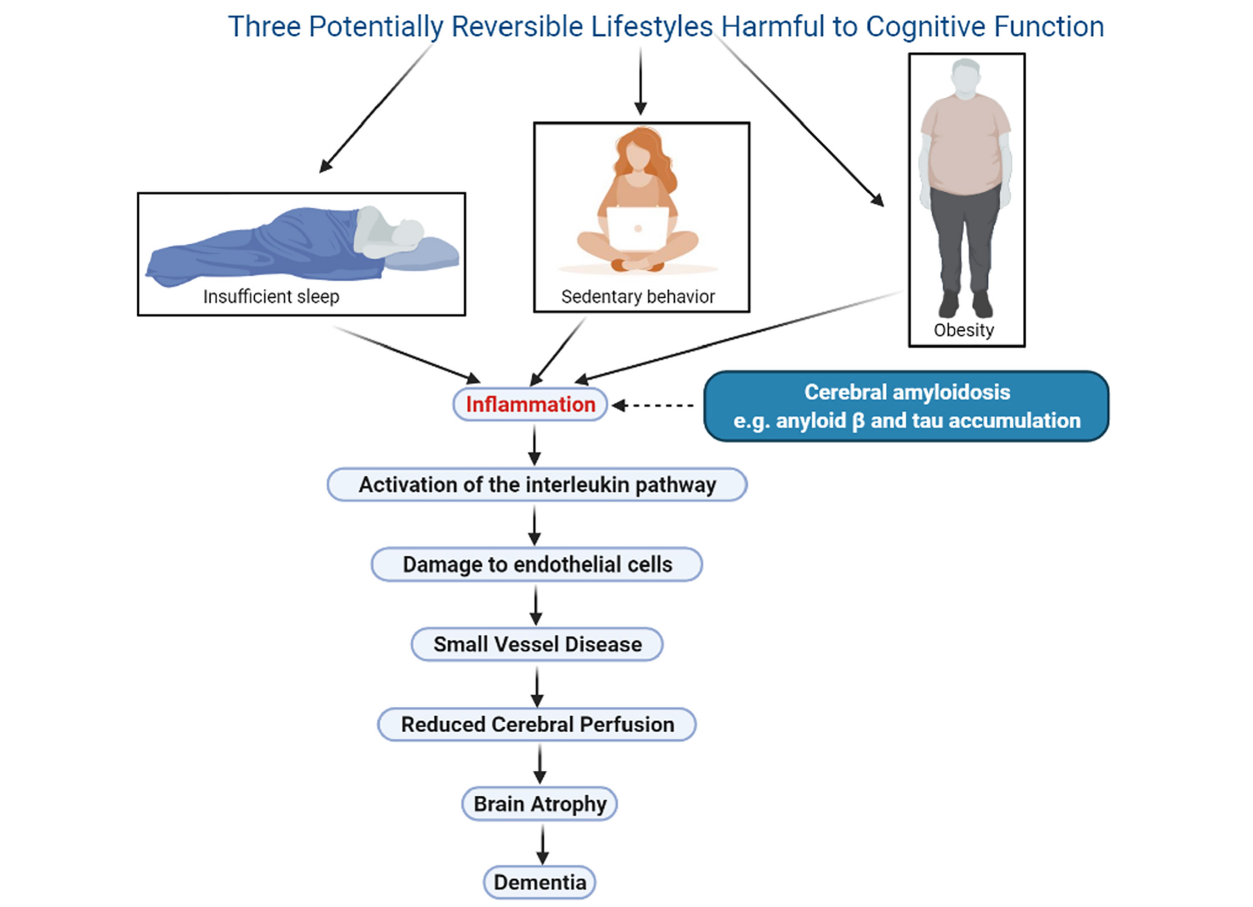
FIGURE 1 | Illustration of a unifying hypothesis that proposes lifestyles that negatively impact cognition do so through the same sequence of events: inflammation, activation of the interleukin pathway, small vessel disease, damage to endothelial cells, decline in cerebral perfusion, and brain atrophy. Three harmful lifestyles are shown, obesity, sedentary behavior and insufficient sleep, all of which are potentially reversible therefore offering an opportunity for meaningful therapeutic interventions. Cerebral amyloidosis may play a synergistic role in this sequence however this phenomenon is currently not reversible. Figure was made in